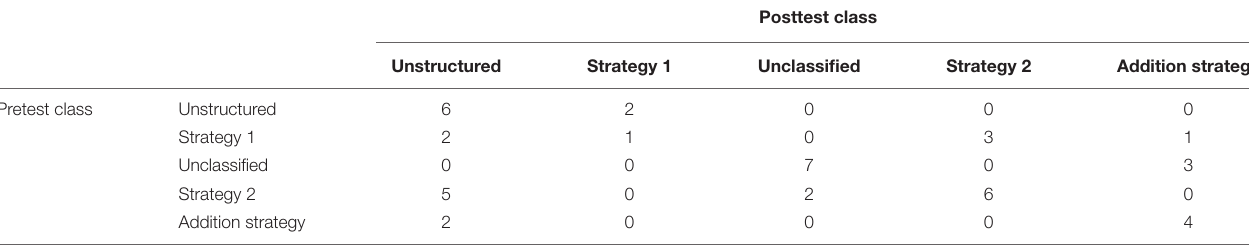
TABLE B1 | Number of children in the control condition who transitioned from pretest to posttest.